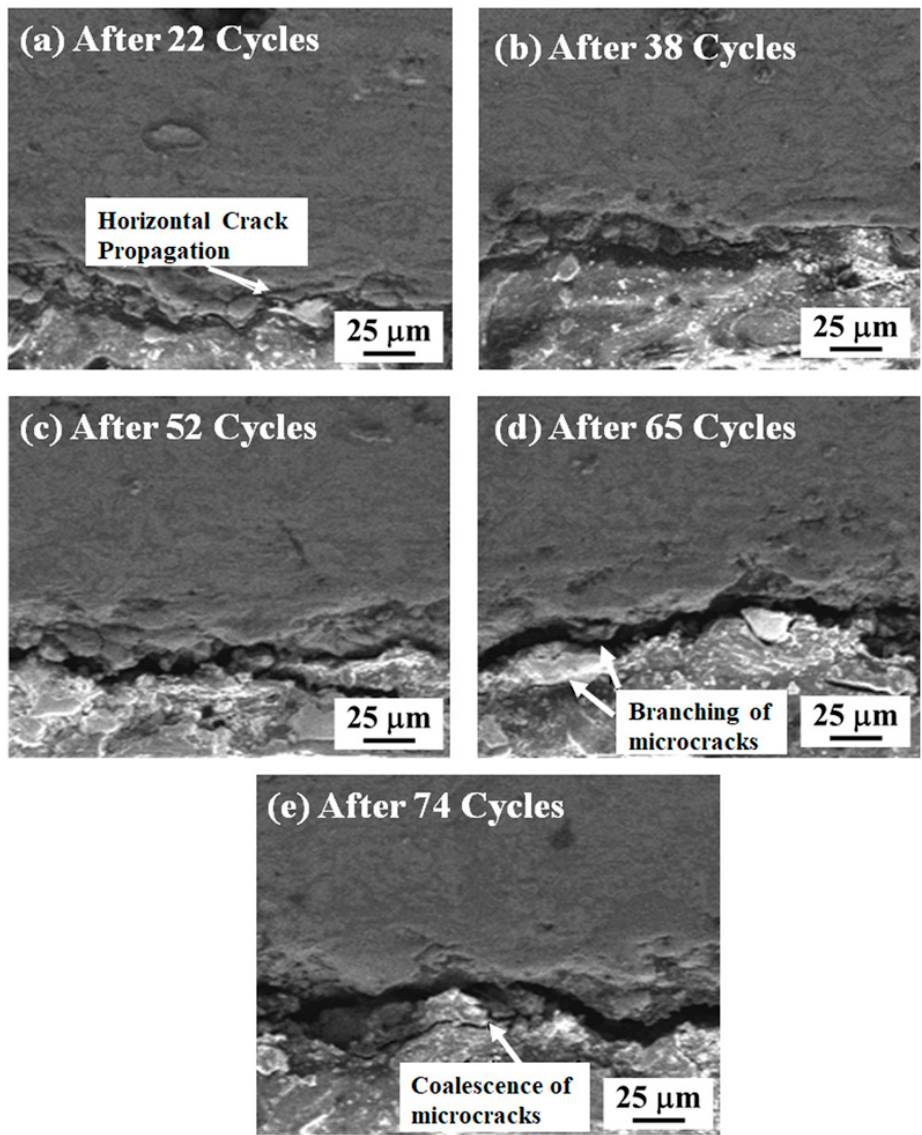
Figure 11. SEM images of as-sprayed DC-TBC after ( a ) 22, ( b ) 38, ( c ) 52, ( d ) 65 and ( e ) 74 heating– quenching cycles.